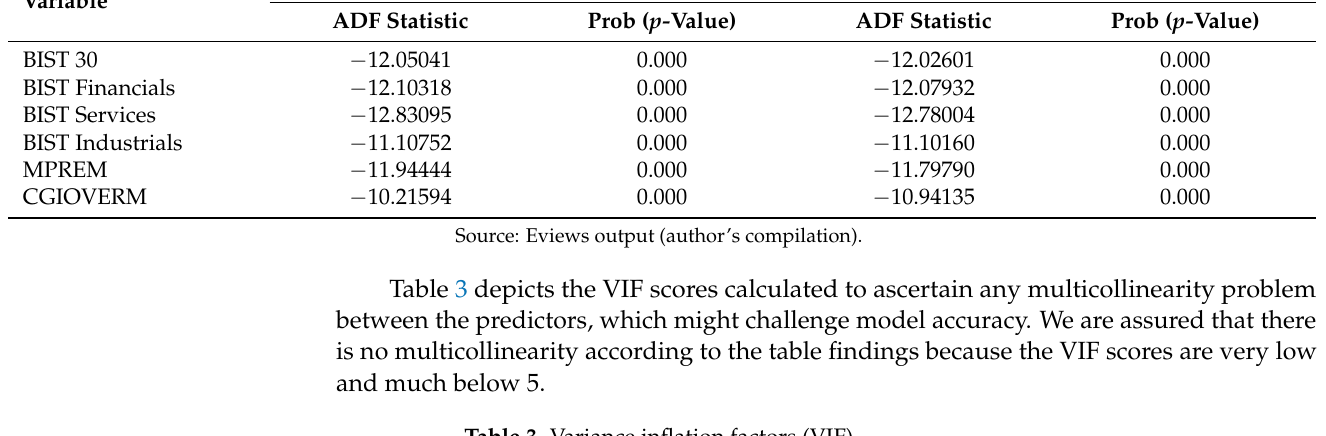
Table 3. Variance inflation factors